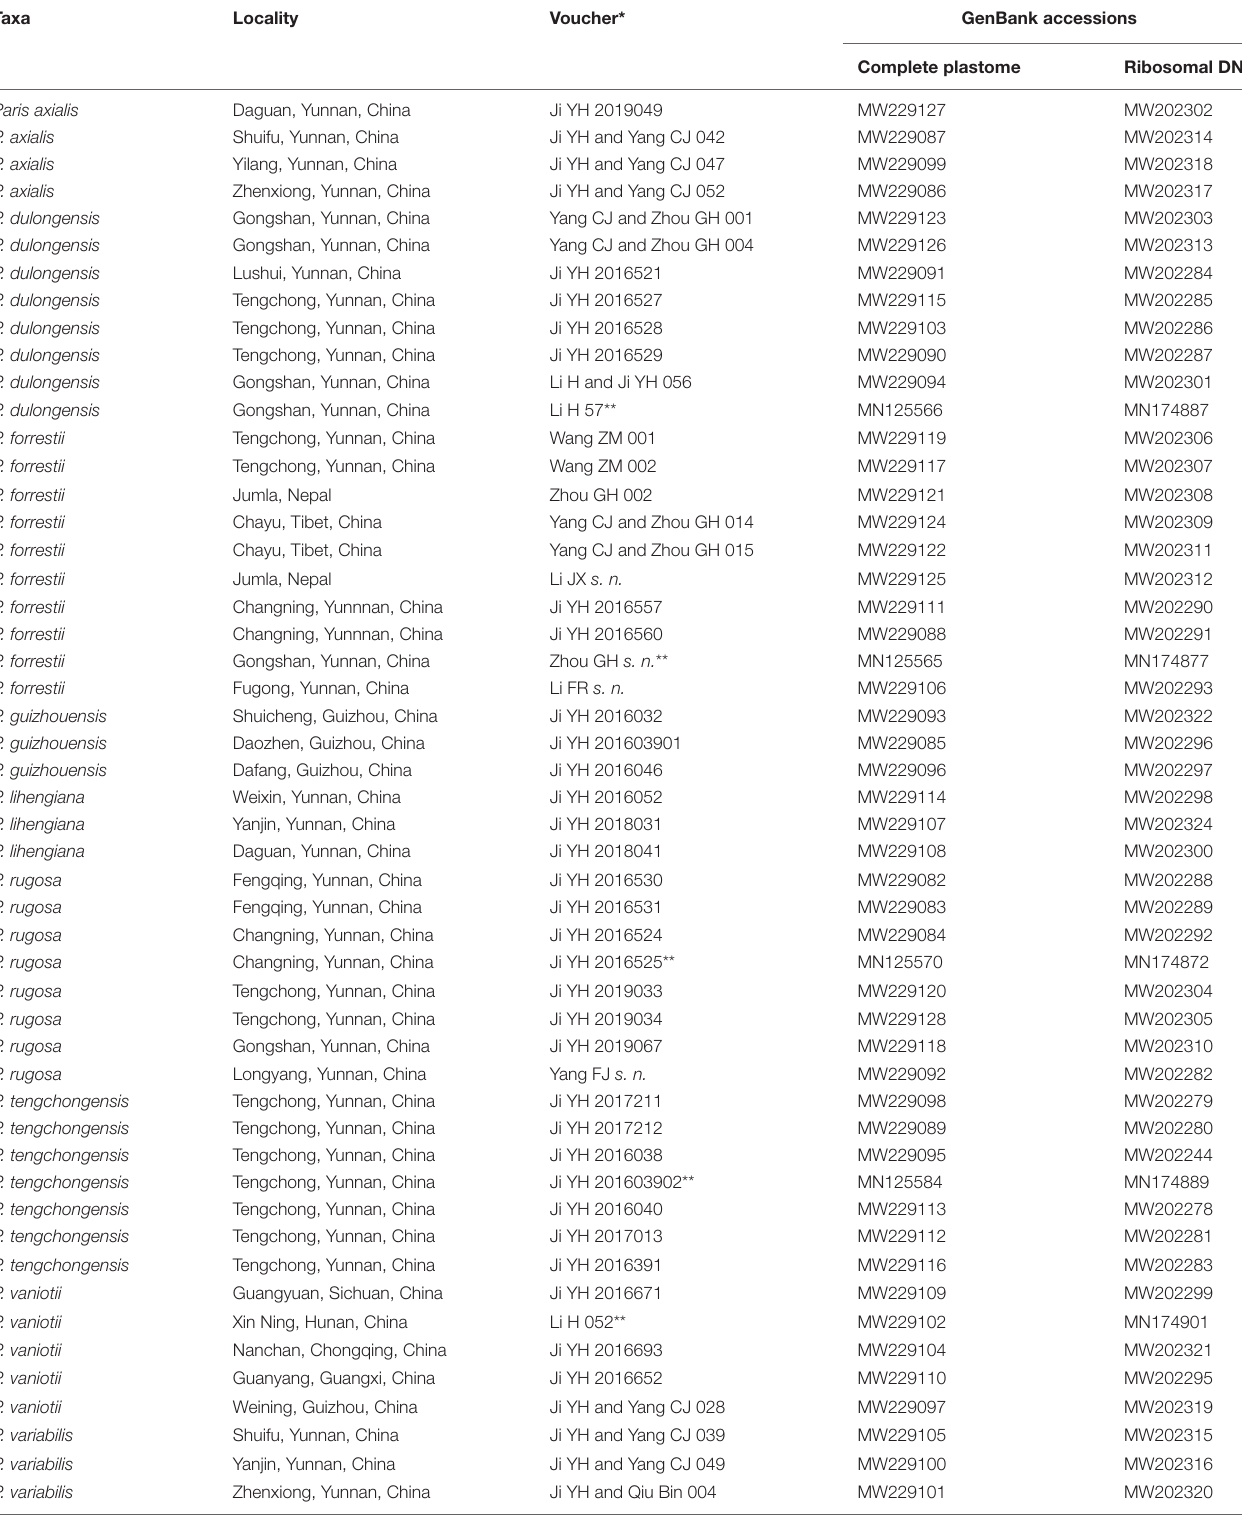
TABLE 1 | Plant samples used in this study with voucher information and GenBank accession numbers.